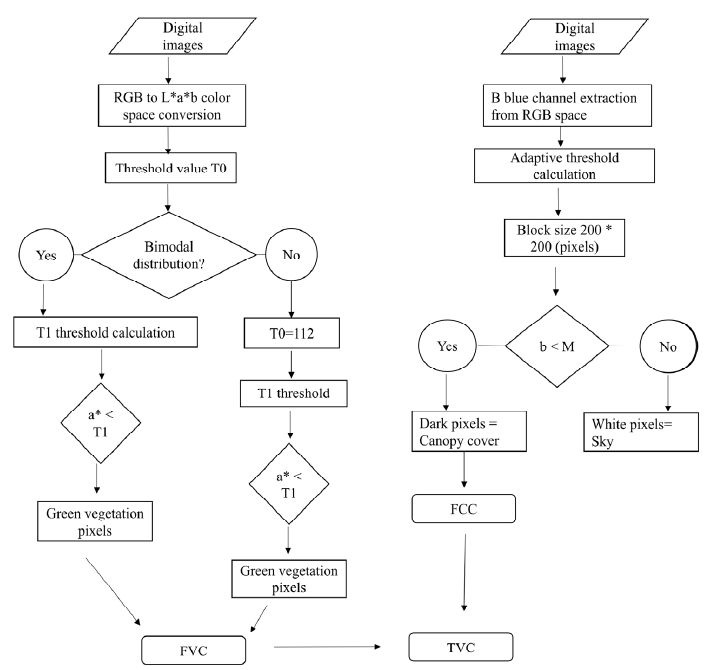
Figure 5. Identification of the optimal T 1 threshold in a bimodal distribution